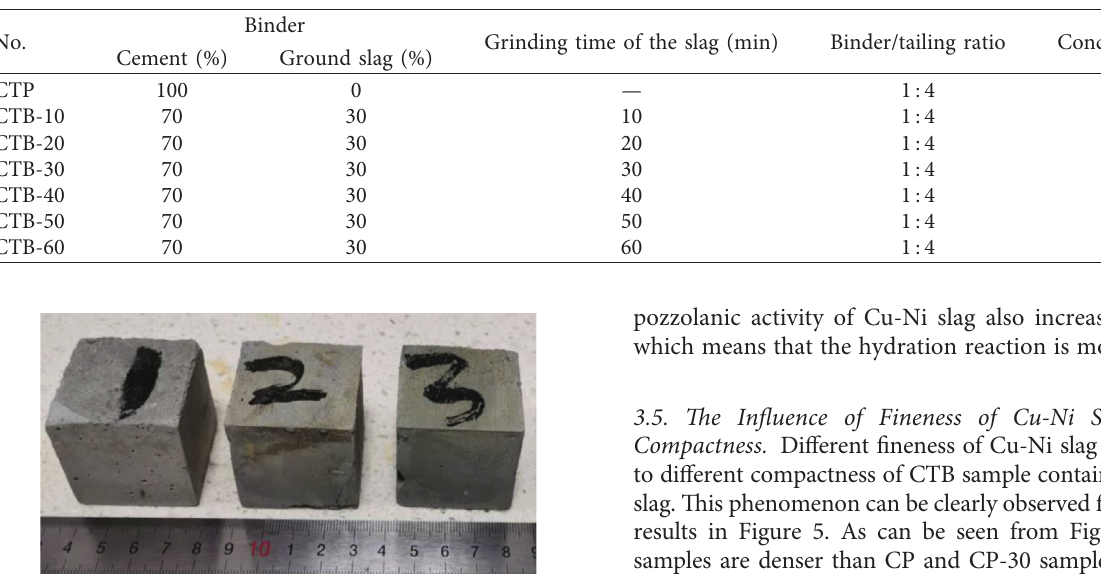
Table 6: The composition of the cemented tailing paste samples.